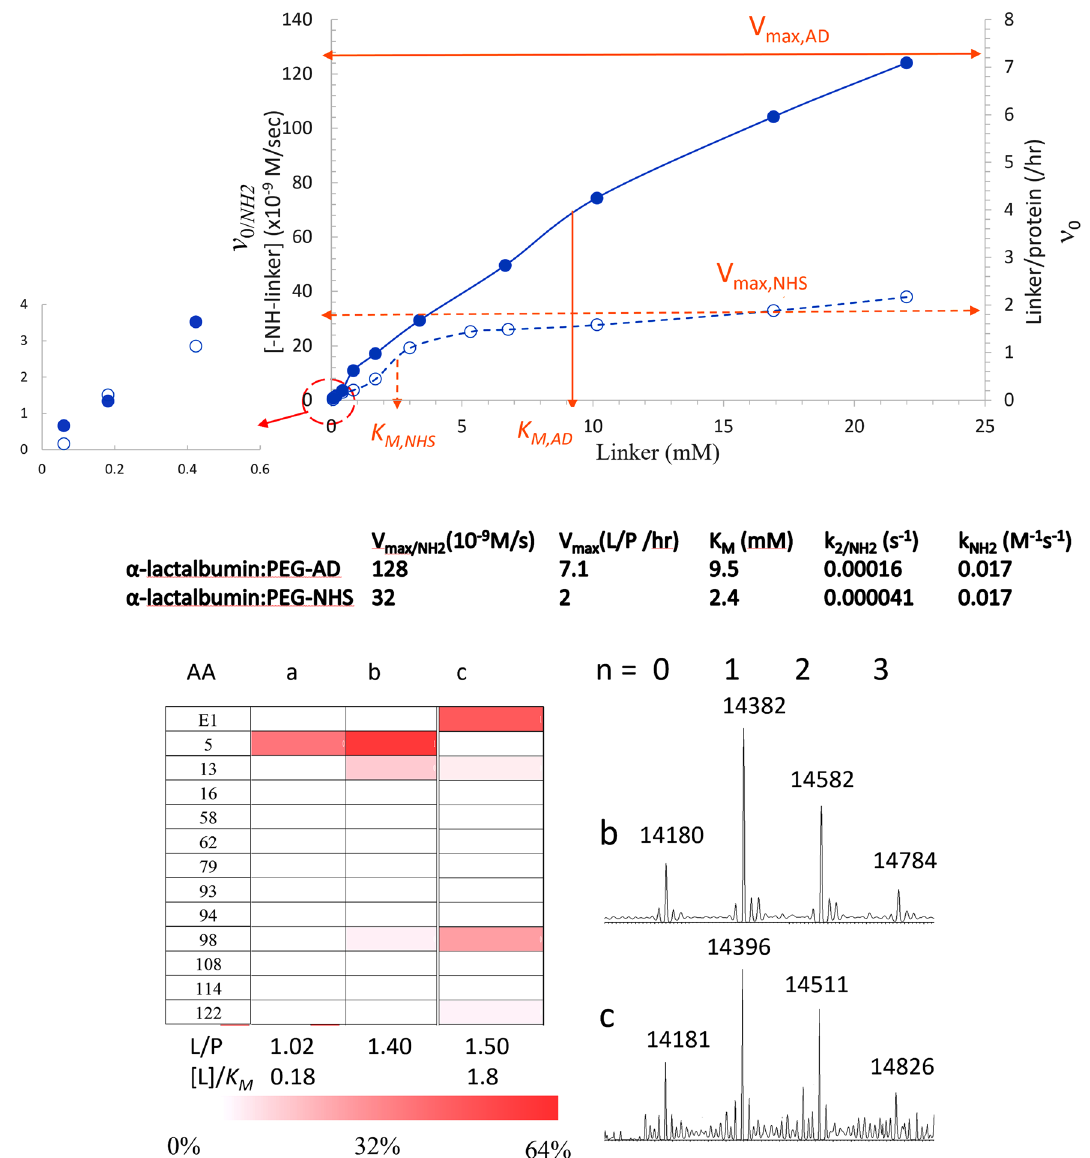
Figure 4. Comparability study of α-lactalbumin (100 μg). Modified Michaelis–Menten plots (top) for bioconjugation of AD-PEG-N 3 (closed) versus NHS-PEG-N 3 (open). The determined parameters from the plot were indicated in below. Distribution of the conjugation sites (bottom) obtained by reaction with a: AD-PEG-N 3 (1.67 mM) for 1 h, b: AD-PEG-N 3 (1.67 mM) for 3 h, and c: NHS-PEG-N 3 (4.41 mM) for 1 h. The corresponding intact spectra of b and c were shown in the